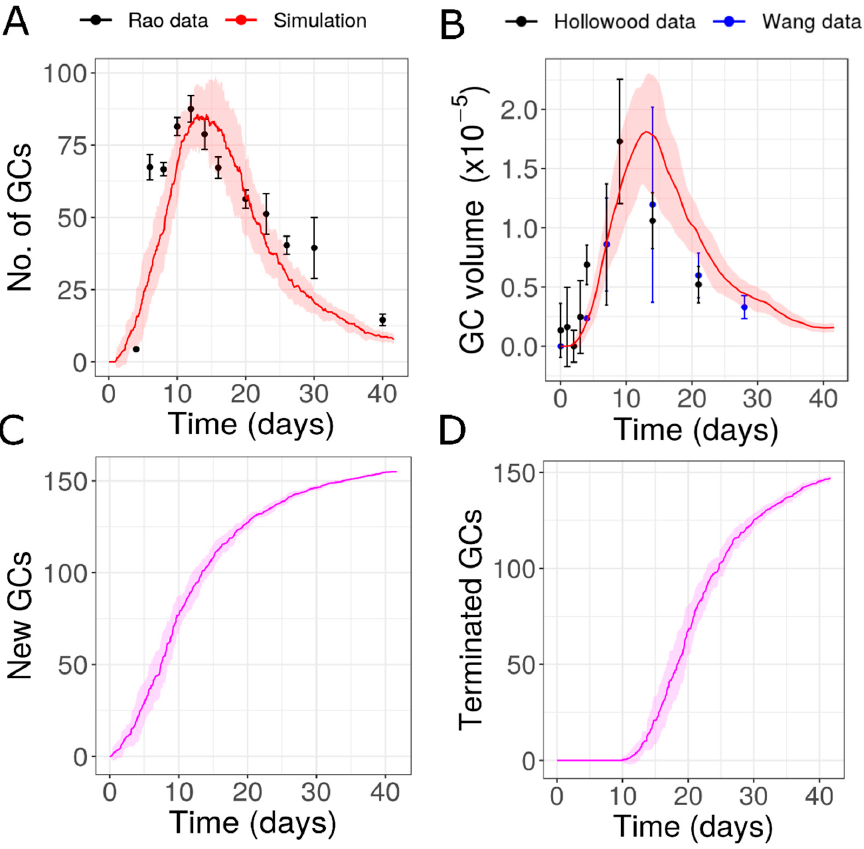
Figure 2. Simulation of GCs with similar characteristics formed over an extended period of time as shown in Figure S1B: ( A ) Dynamics of number of GCs in simulation compared to data from [31], ( B ) total GC volume compared to data from [13,45] ( C ) cumulative number of new GCs initialized, ( D ) cumulative number of terminated GCs. GC volume data from [13,45] were normalized with respect to the simulation result on day 7. GC: Germinal Center.